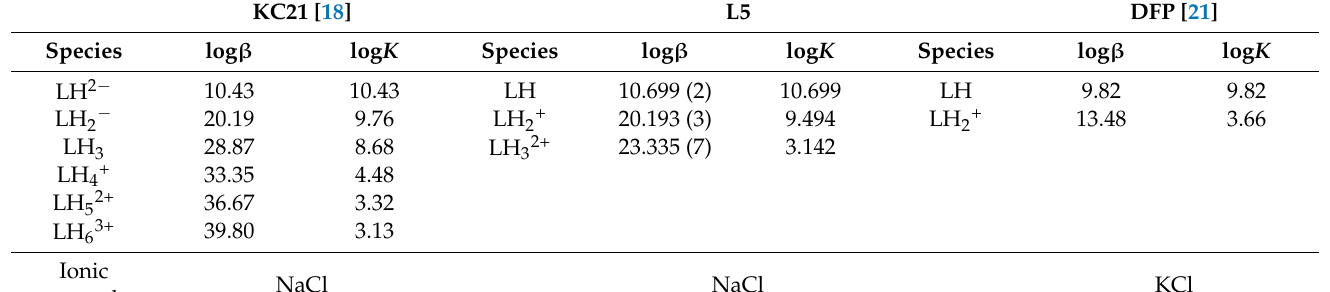
Table 1. Protonation constants of KC21, L5 and DFP ligands evaluated from combined potentiom- etric – UV spectrophotometric titrations at 25 °C, 0.1 M ionic strength. L indicates the completely deprotonated form of ligands. The digits in brackets represent the standard deviation calculated by HypSpec program [20].